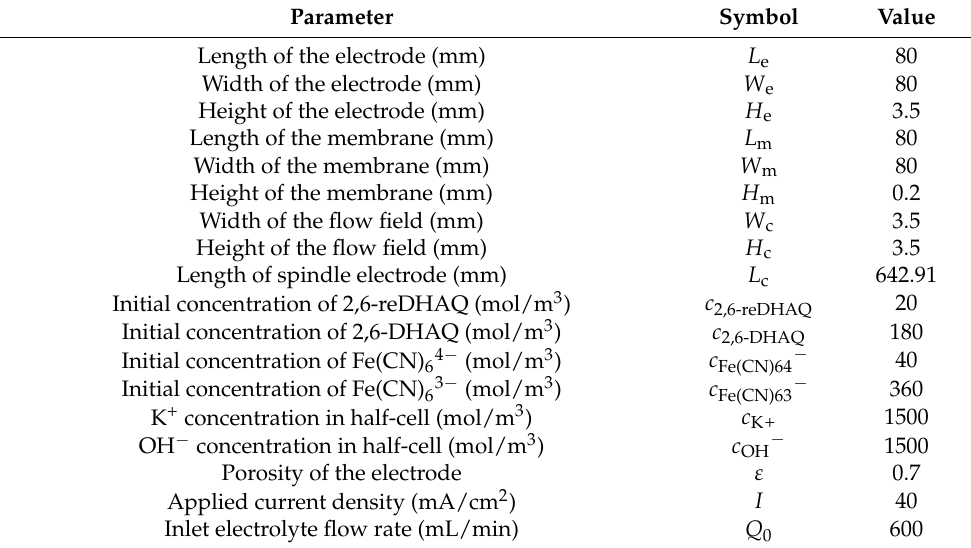
Table 3. Geometric and operation parameters used in the simulation.